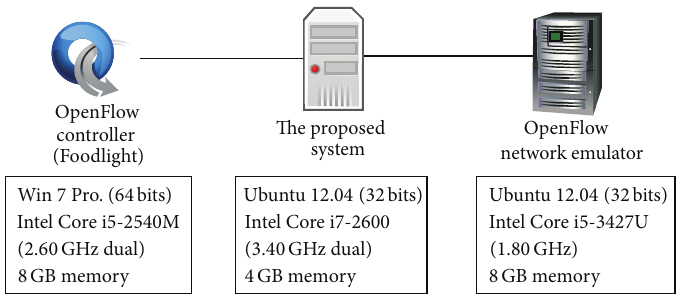
Figure 9: Experimental environment (physical layout) in this paper.